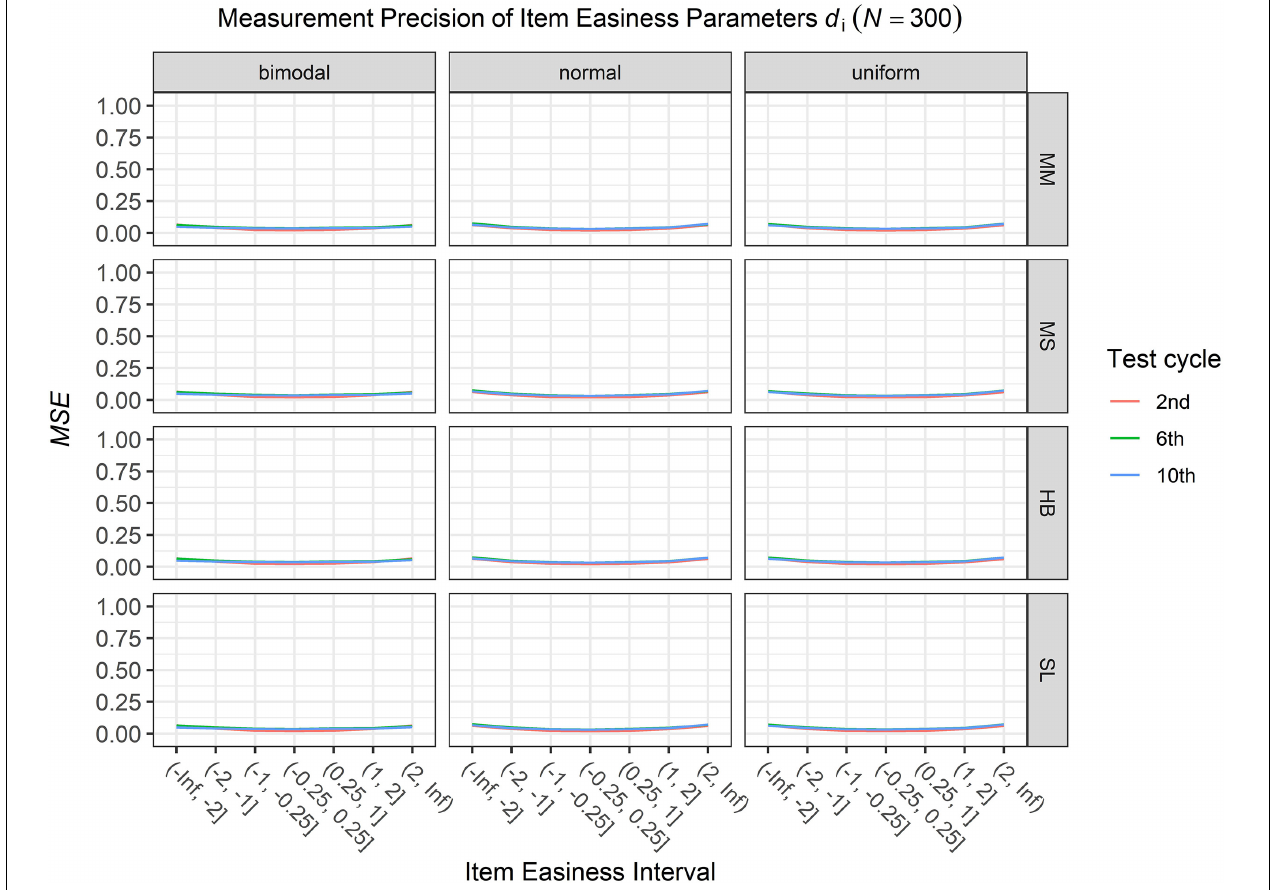
FIGURE 6 | Conditional mean squared error ( MSE ) of the item easiness d i for specific item easiness intervals after the 2nd, 6th, and 10th test cycle in the continuous calibration strategy with a sample size per test cycle of N = 300 for different common item difficulty distributions and different scale transformation methods (MM = Mean/Mean, MS = Mean/Sigma, HB = Haebara, SL =